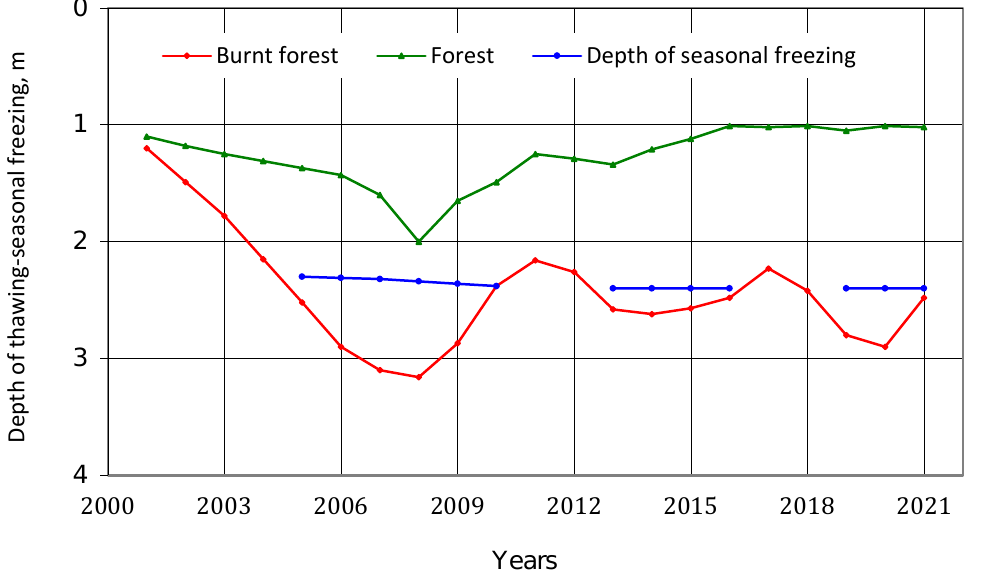
Figure 11. Variation in the seasonal thaw depth in the forest and the burned/cleared site in the inter-alas terrain type along the Mastakh–Yakutsk gas pipeline.